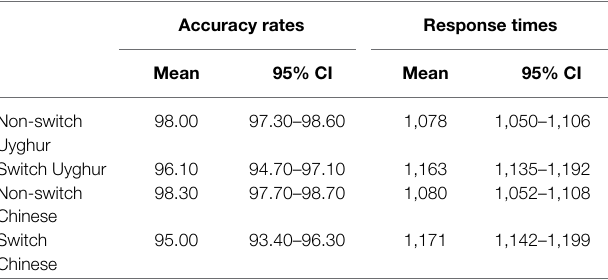
Dominance stands for Language Dominance. Significant statistics are demonstrated in bold. TABLE 3 | Mean accuracy rates (%), mean correct response times (ms) and the 95% confidence intervals (CI) from the lower level to the upper level for the picture naming task by Switch Type and